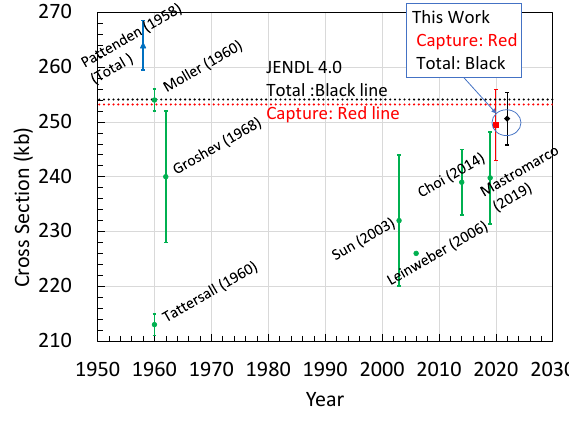
Table 3. E ff ective thickness and measurement time of samples for capture cross section measurement. Figure 4. Obtained preliminary capture cross section of 157 Gd at neutron energy of 0.0253 eV, and comparisons to capture cross sections (Green) and a total cross section (Blue) in literatures and the evaluated values in JENDL 4.0. Figure 2. Ratios of capture yields for the 155 Gd and 157 Gd sam- ples.